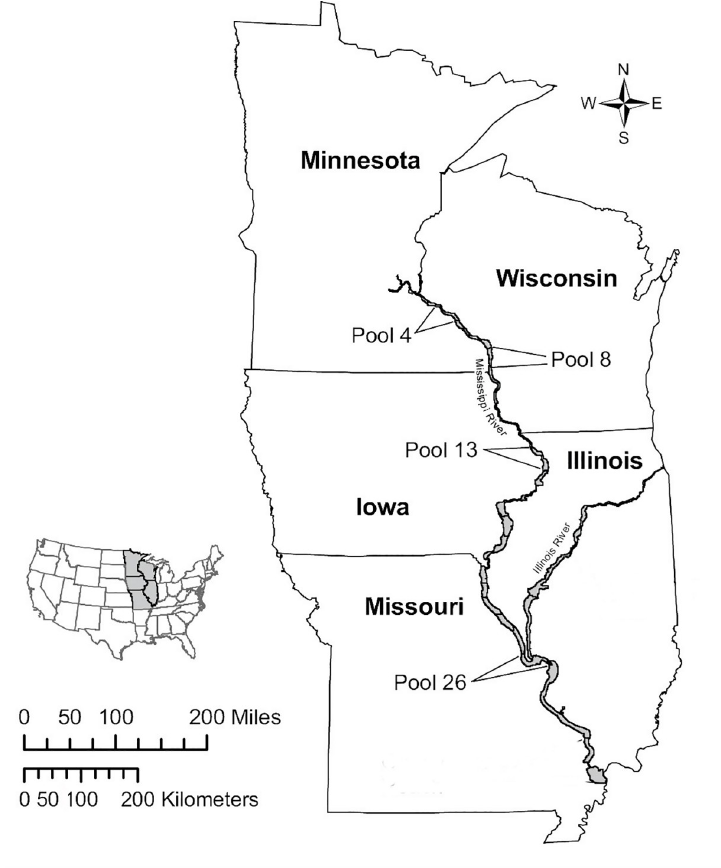
Fig 1. Locations of U.S. Army Corps of Engineers’ Upper Mississippi River Restoration, Long Term Resource Monitoring element sampling locations within the upper Mississippi River that are used in this study. Original map appears in